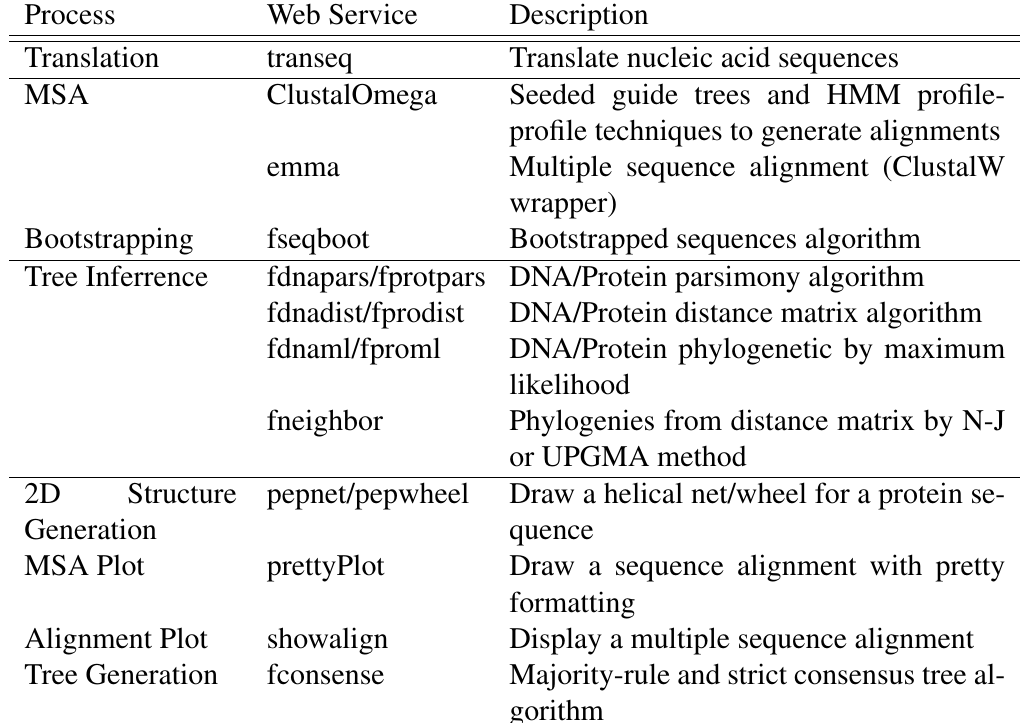
Figure 3: The preliminary integrated workflow of tree inferring algorithms in a collapsed display Table 1: Relevant web services for the proposed